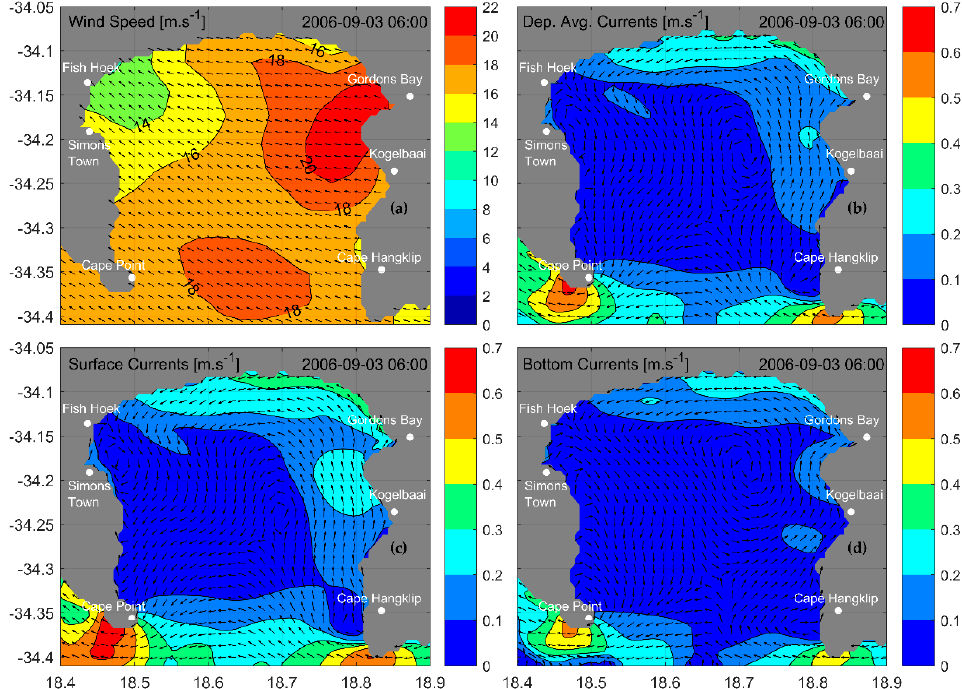
Figure 10. Anti-clockwise depth-averaged ( b ), surface ( c ) and bottom ( d ) flows in False Bay, set up by stronger westward flow in the north-eastern reaches in the absence of the wind shadow ( a